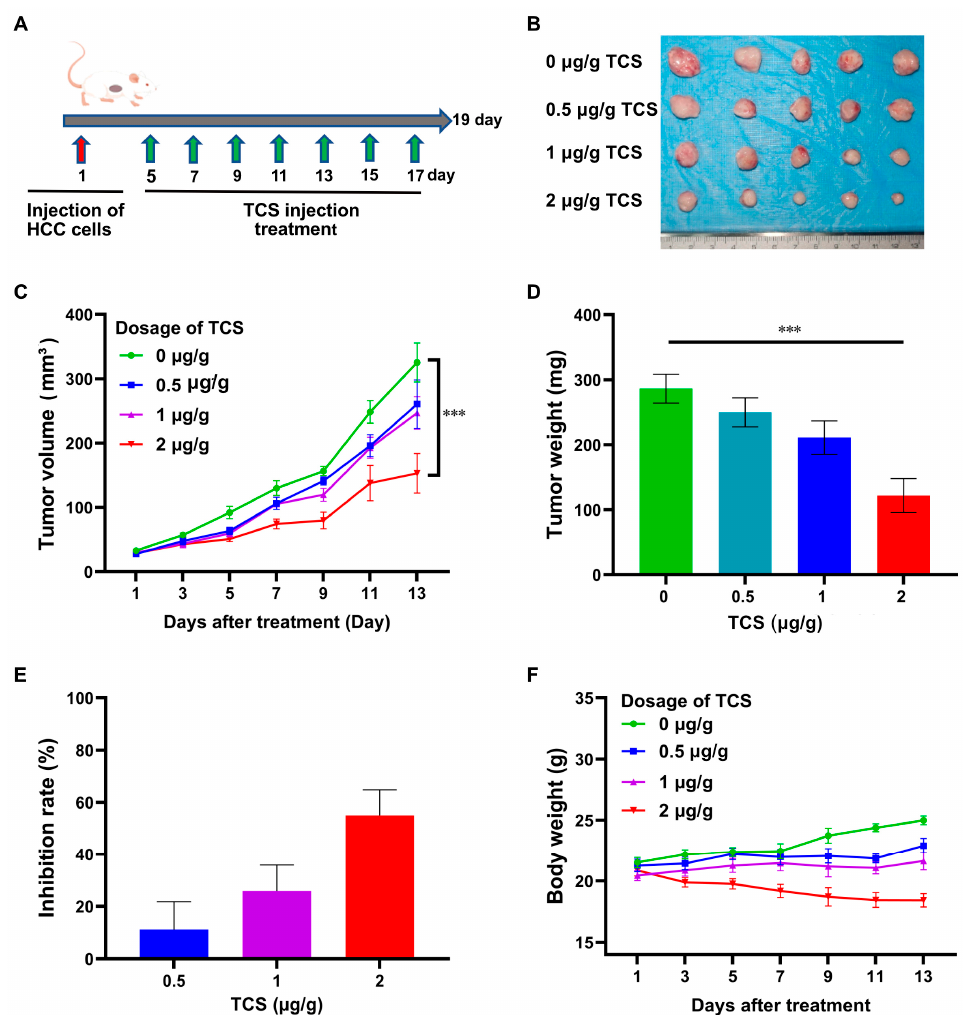
Figure 3. Effects of TCS on apoptosis and autophagy of HCC cells. ( A ) Timeline schedule of mice injected with HCC cells and treated with TCS; ( B ) On day 19, mice were euthanized and tumor tissues were obtained as shown in the figure; ( C – E ) Quantitation of data showed the volume of tumors, weight and the inhibition rate of TCS on the weight of tumor tissue; ( F ) Quantitation of data showed the weight changes in mice treated with varying doses of TCS. ***, p <